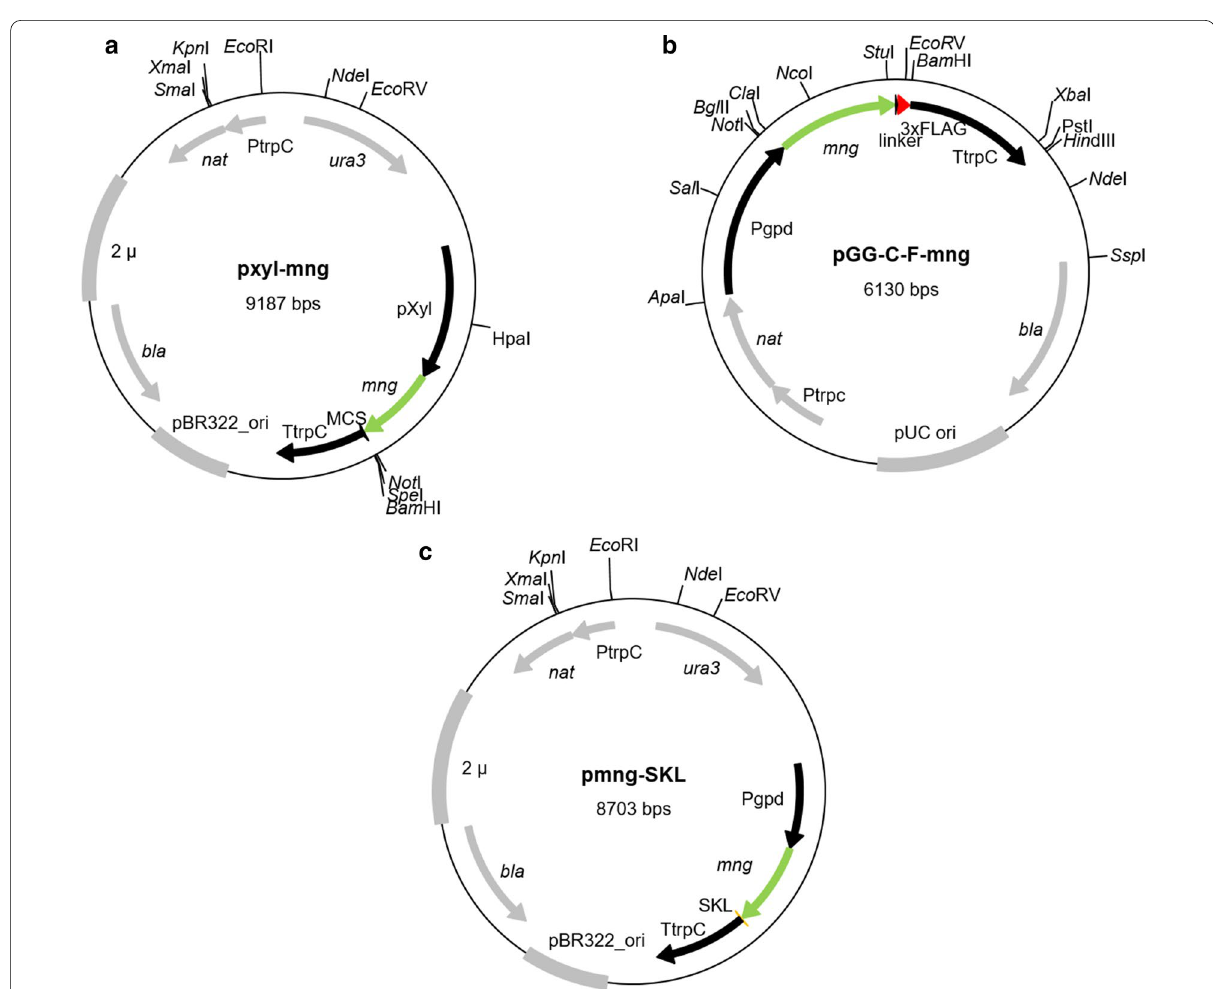
Fig. 1 Physical maps of mNG plasmids. a pxyl-mng, b pGG-C-F-mng, c pmng-SKL The ampicillin resistance cassette ( bla ) and the ori for selection and replication in E. coli are indicated. The nourseothricin resistance gene nat1 is under control of the A. nidulans trpC promoter (PtrpC) can be used for selection of fungal transformants. The 2 µ ori and the ura3 gene can be used for transformation of S. cerevisiae . The mng ORF (green arrow) is either regulated by the xylose inducible Smxyl promoter of S. macrospora (Pxyl) or the gpd promoter A. nidulans (Pgpd) and the trpC terminator of A. nidulans (TtrpC). Plasmid pxyl-mng contains a multiple cloning site (MCS). In plasmid pGG-C-F-mng a C-terminal 3 (DYKDHD-G-DYKDHD-I-DYKDDDDK, red arrow) is fused via a short linker (GSGSG) to mNG. In plasmid pmng-SKL the peroxisomal targeting sequences SKL (orange arrow) is fused to the C-terminus of